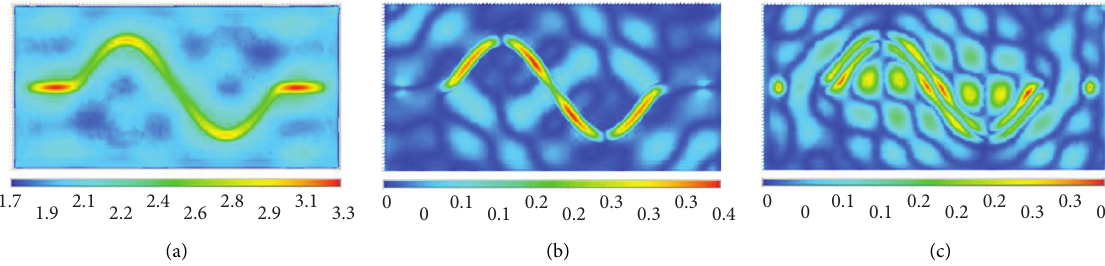
Figure 46: SV wave incident ( C